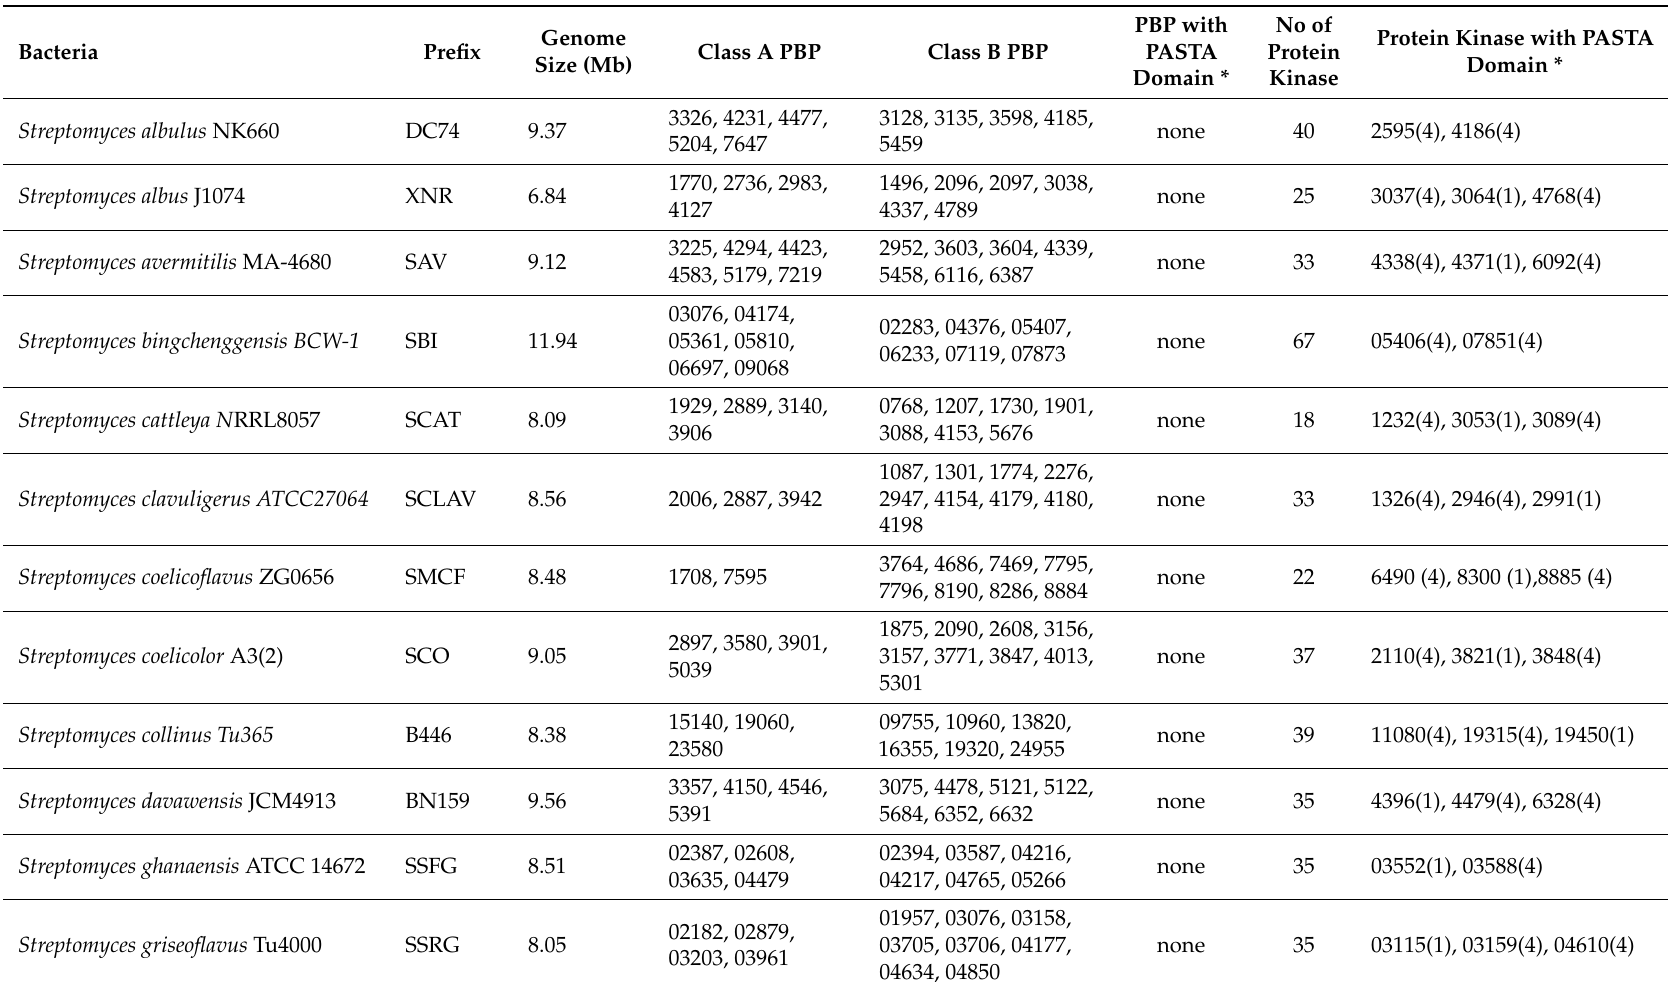
Table 6. The numbers and types of putative PBP and protein kinase